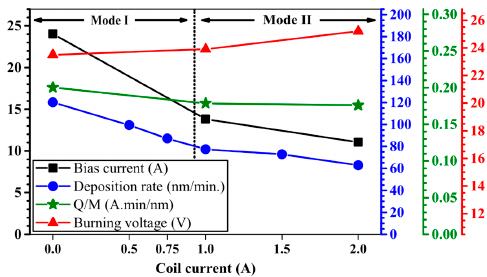
/ M ), and burning voltage as a